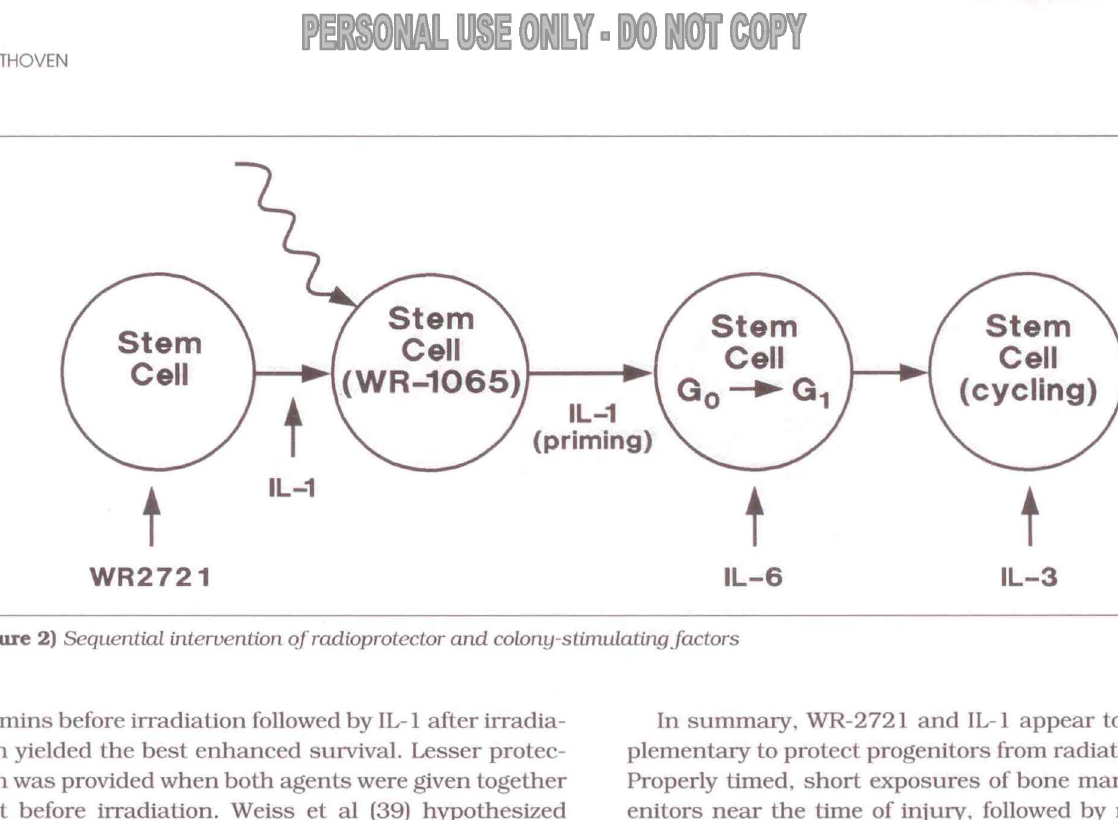
Figure 2) Sequential intervention of radioprotector and colony-stimulating factors